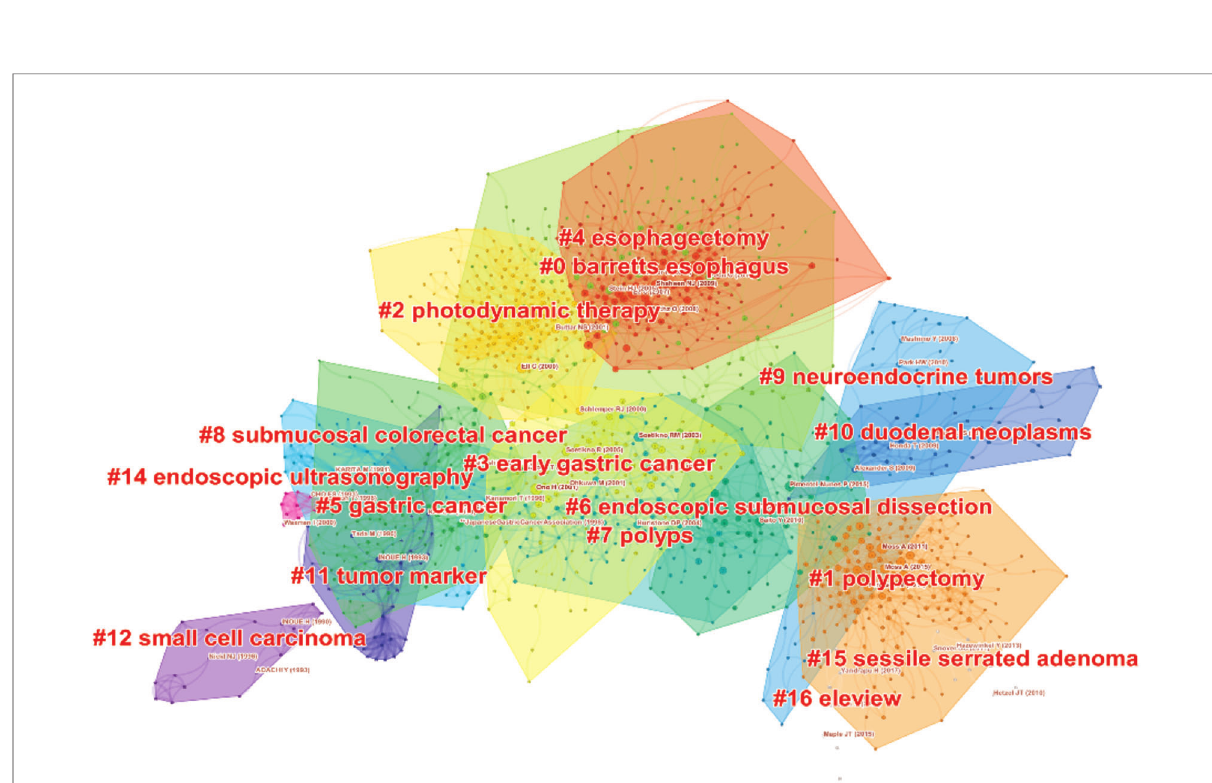
FIGURE 7 The cluster network